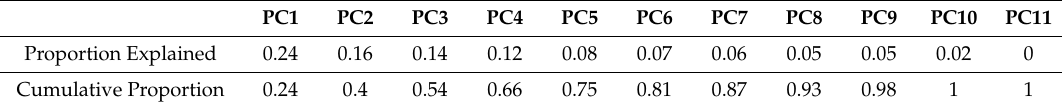
Table 5. The variability proportion explained by components (PC1–PC11).